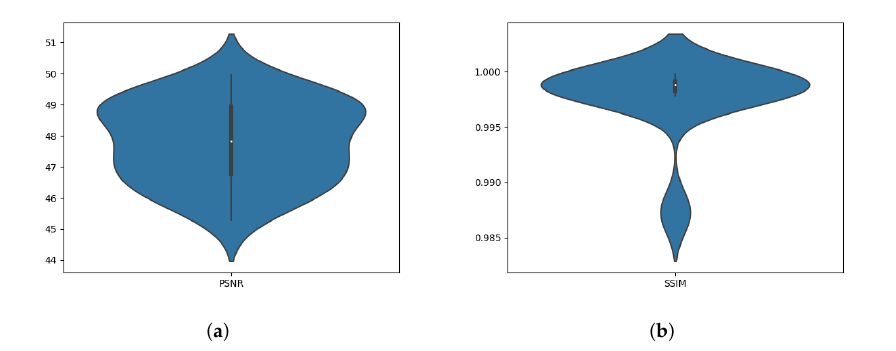
Figure 9. The violin plot of all 30 test images: ( a ) Violin plot of the PSNR calculated between original and watermarked images, ( b ) Violin plot of the SSIM calculated between original and watermarked